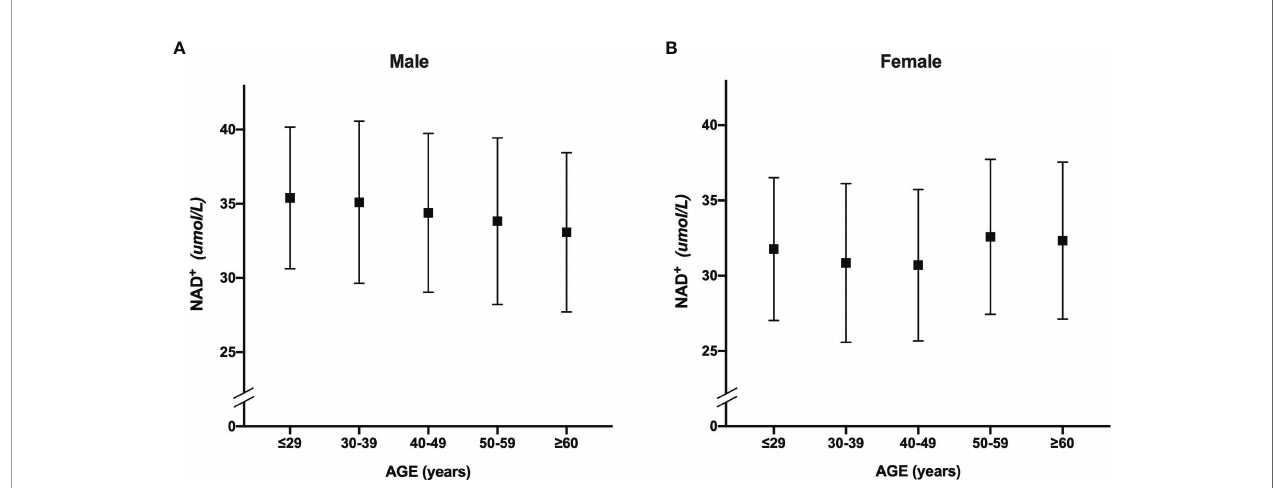
FIGURE 3 | The trend of whole blood NAD + contents with aging in men and women. (A) The trend of whole blood NAD + contents with aging in males. (B) The trend of whole blood NAD + contents with aging in females. The dots and error bars represent mean and standard deviation of blood NAD + contents in fi ve age groups, respectively.